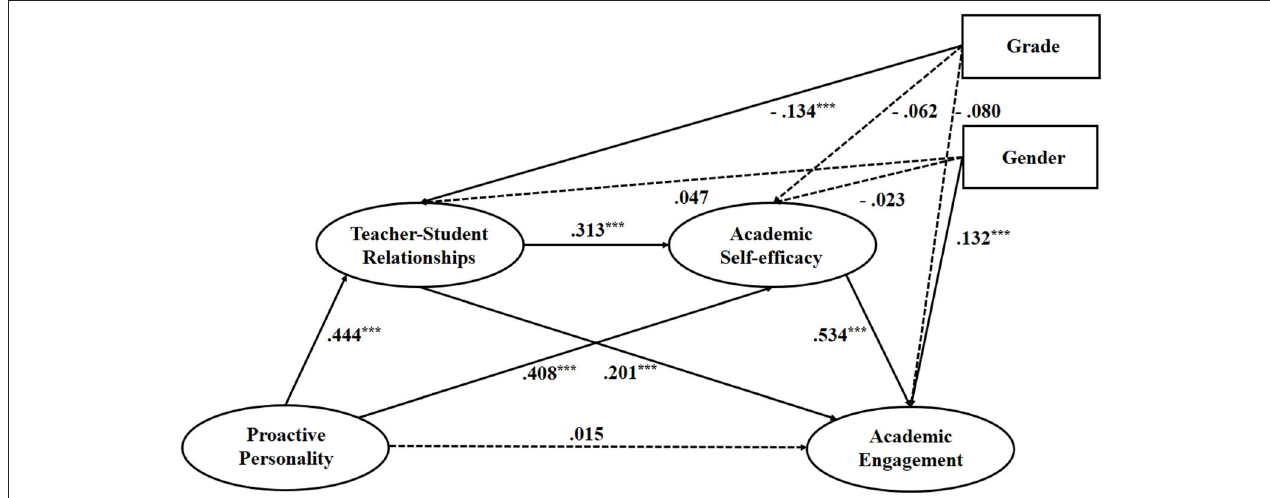
FIGURE 2 | The serial mediation model with teacher-student relationship and academic self-efficacy as mediators of the linkage between proactive personality and academic engagement. gender and grade, correlations between all main variables were significant and